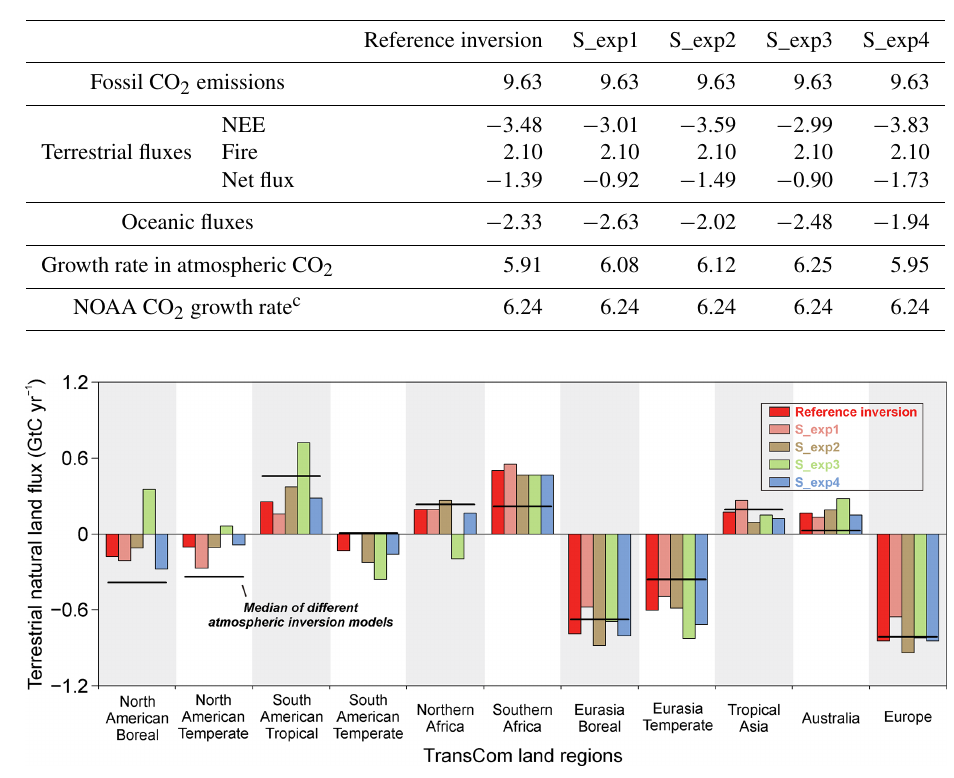
Table 4. Global anthropogenic CO 2 budget for 2015 derived from our reference inversion results and four sensitivity inversion experiments. All values shown here represent the global total fluxes for 2015 in GtCyr − 1 .